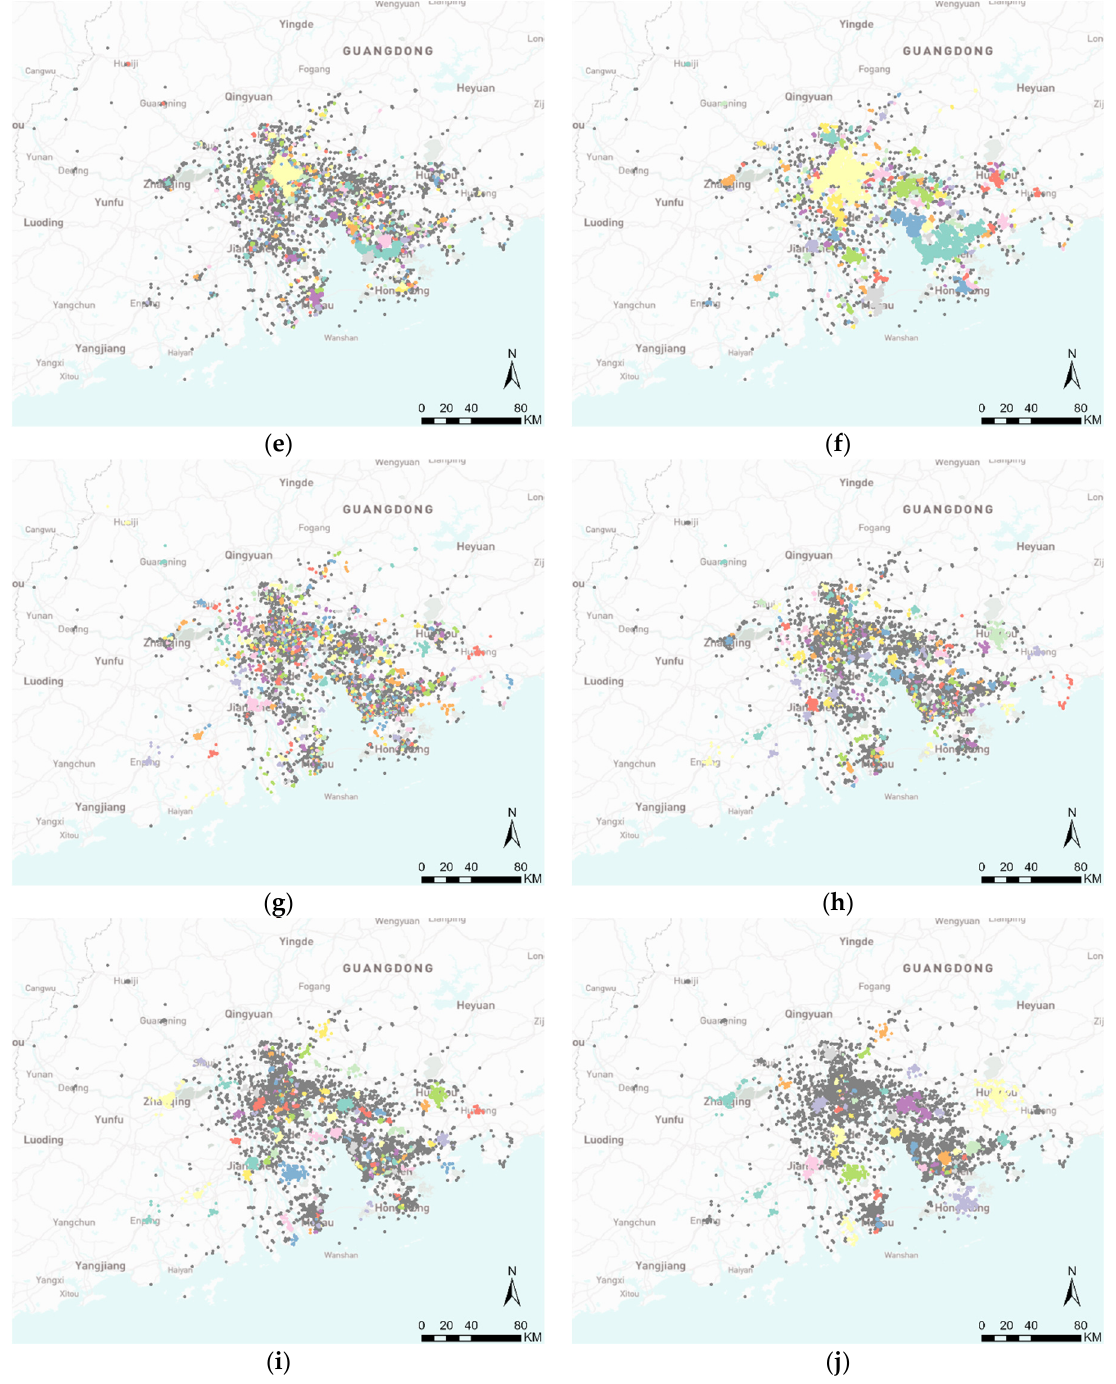
Figure 9. Clustering results of different methods tested on the first day data in GBA dataset: ( a ) ELV, ( b ) DPC, ( c ) DBSCAN 200, ( d ) DBSCAN 400, ( e ) DBSCAN 800, ( f ) DBSCAN 1600, ( g ) HDBSCAN 4, ( h ) HDBSCAN 8, ( i ) HDBSCAN 16, and ( j ) HDBSCAN 32. The points colored gray were noises and points with other colors were clustered points.